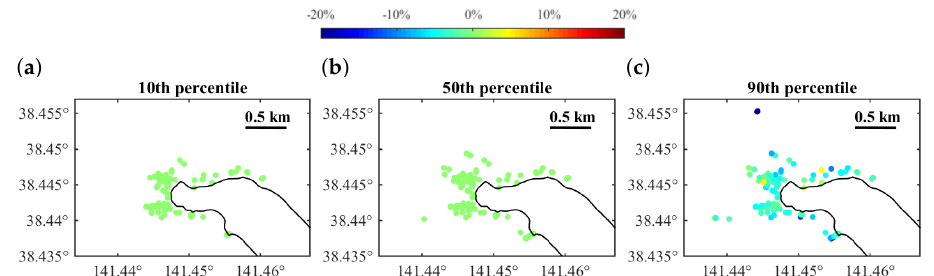
Figure 13. Distribution of loss difference for RC structures of region R1 in Onagawa: ( a ) 10th percentile; ( b ) 50th percentile; and ( c ) 90th percentile.